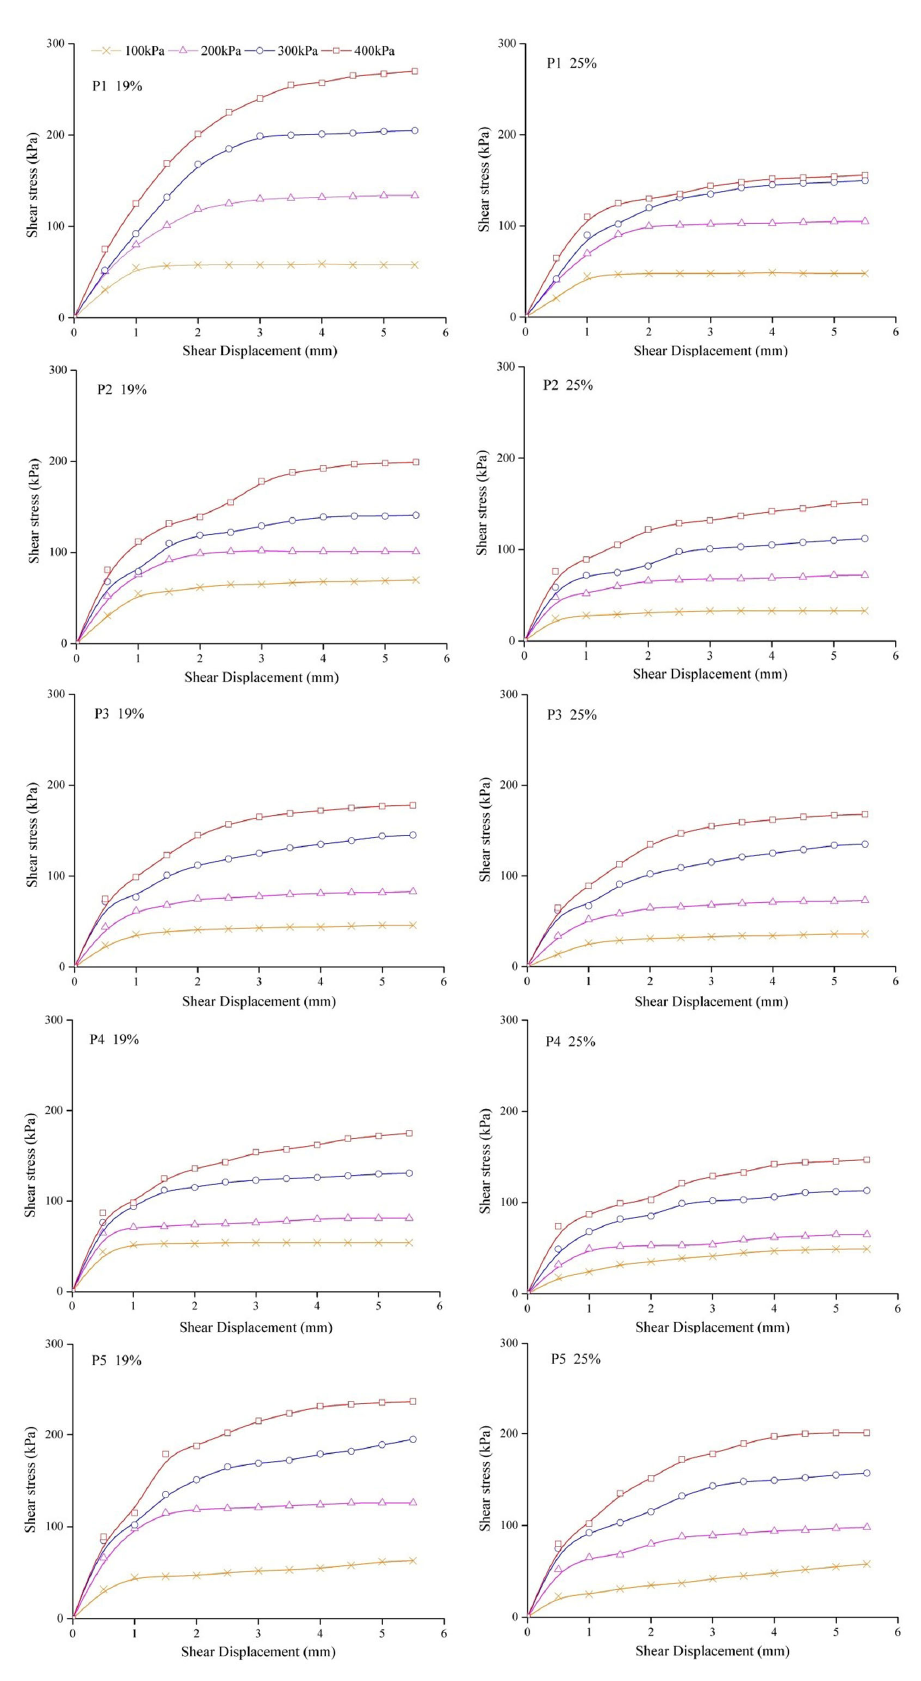
Figure 4. Typical shear-strength-displacement curves for di ff erent sample points (P1, P2, P3, P4, and P5) at di ff erent moisture contents (19% and 25%) and net normal stresses (100, 200, 300, and 400